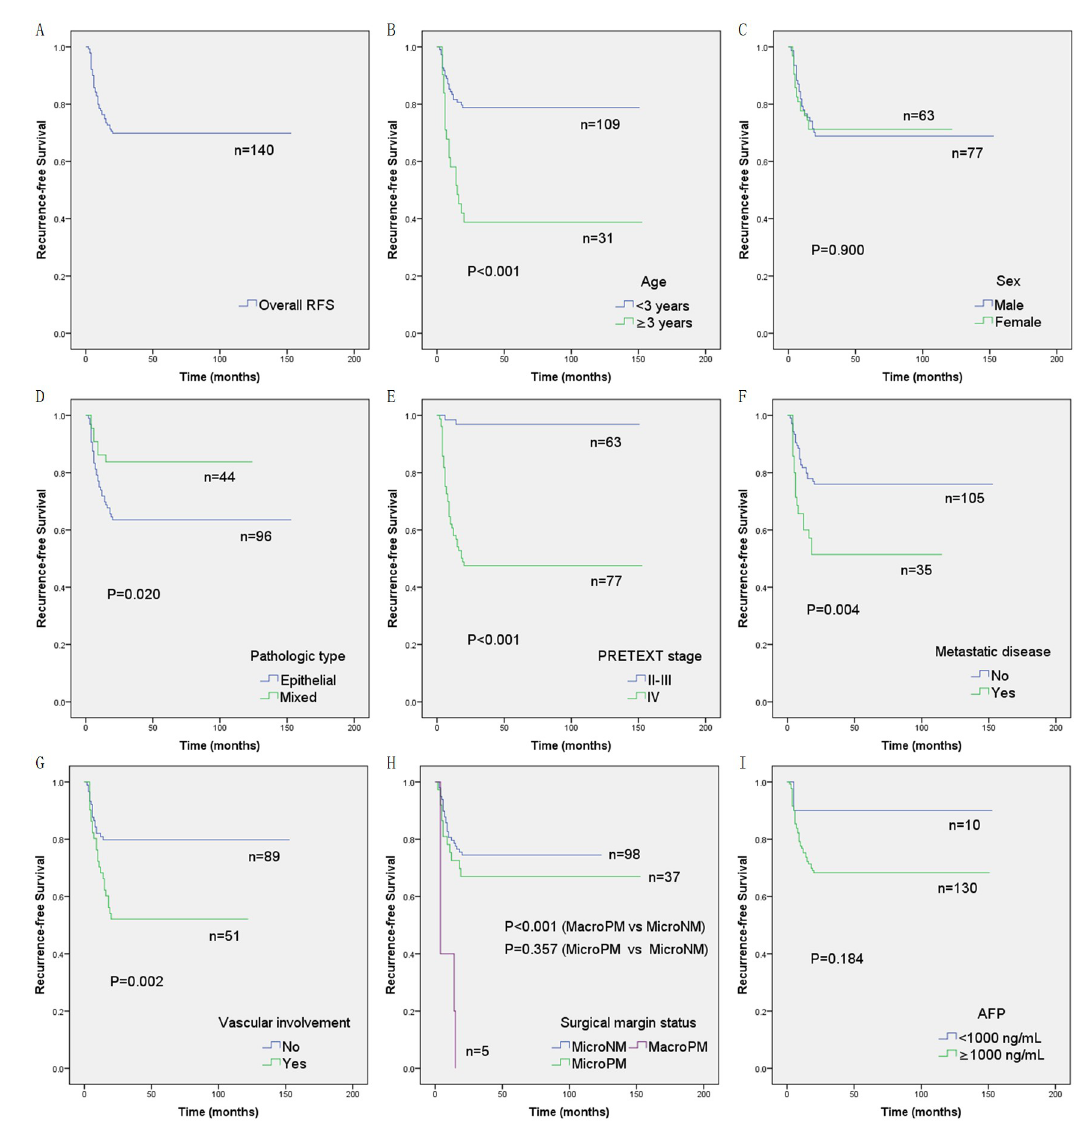
Fig 3. Overall recurrence-free survival (RFS) and comparisons of RFS by age, sex, pathologic type, PRETEXT stage, metastatic disease, vascular involvement, surgical margin status, and serum AFP level. (A) Overall RFS. (B) Comparison of RFS by age. (C) Comparison of RFS by sex. (D) Comparison of RFS by pathologic type. (E) Comparison of RFS by PRETEXT stage. (F) Comparison of RFS by metastatic disease. (G) Comparison of RFS by vascular involvement. (H) Comparison of RFS by surgical margin status, including macroscopically positive margin (MacroPM), microscopically positive margin (MicroPM), and microscopically negative margin (MicroNM). (I) Comparison of RFS by serum AFP level. (Kaplan-Meier method, P value shown for Log-rank test between